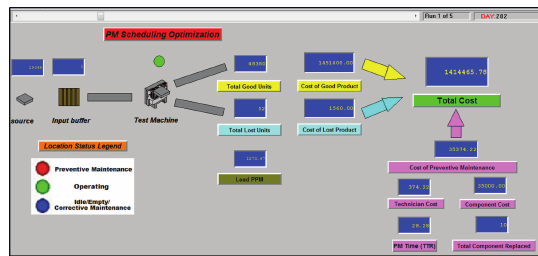
Figure 4: Complete simulation model for PM scheduling optimiza-